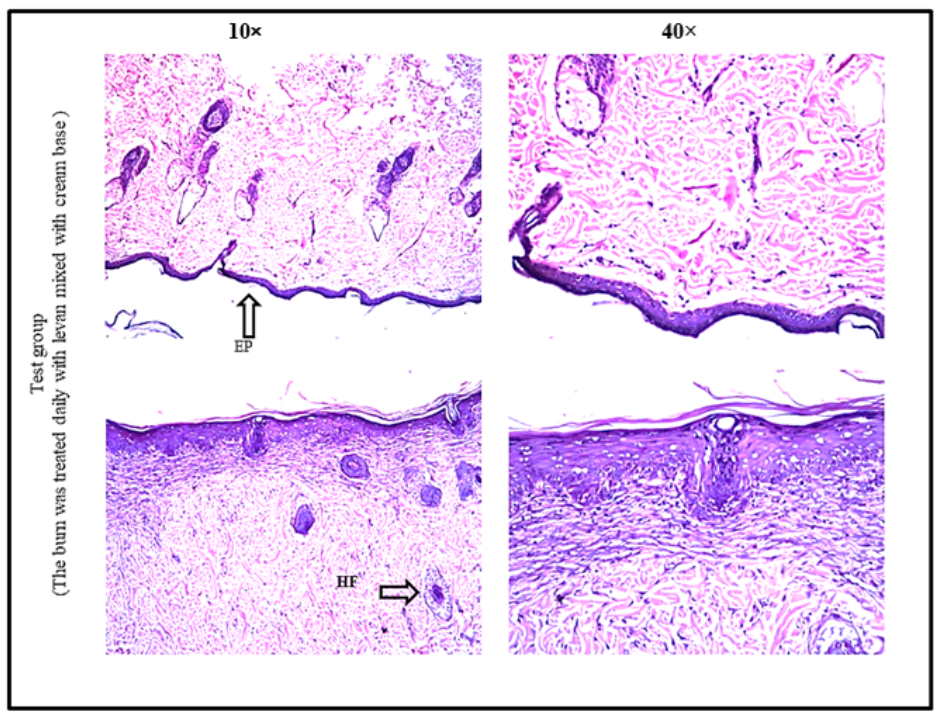
Figure 9. The representative photomicrographs of burned areas from two different rats of test group (treated daily with levan mixed with cream base) stained with hematoxyline eosin on the seventh day of burn induction. Photomicrographs were taken at magnifications of 10× and 40×. Ep, epidermis; HF, hair follicle.